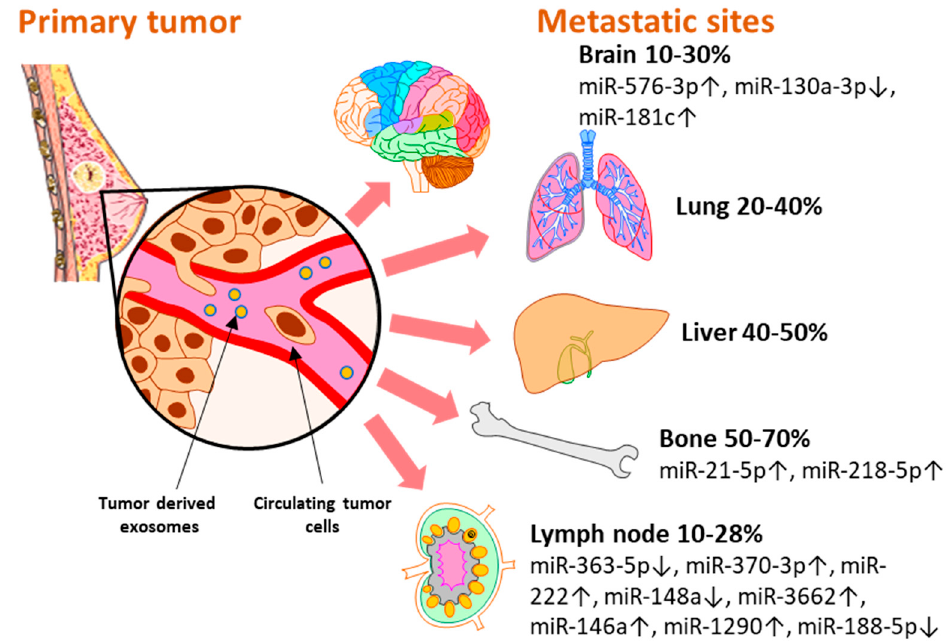
Figure 2. The distribution of miRNAs associated and validated with breast metastasis sites: brain (miR-576-3p, miR-130a-3p, miR-181c), bone (miR-21-5p, miR-218-5p), and lymph node (miR-363-5p, miR-370-3p, miR-222, miR148a, miR-3662, miR-146a, miR-1290, miR-188-5p). Breast cancer has several preferential metastasis sites, with different incidences of secondary lesions. Exosomal miRNAs released by tumor cells have been investigated as blood-based biomarkers for metastasis prediction with regard to the metastatic site. Several miRNAs reported in the literature have been validated in liquid biopsy samples of breast cancer patients and represent potential biomarkers with immediate applicability for the clinic.